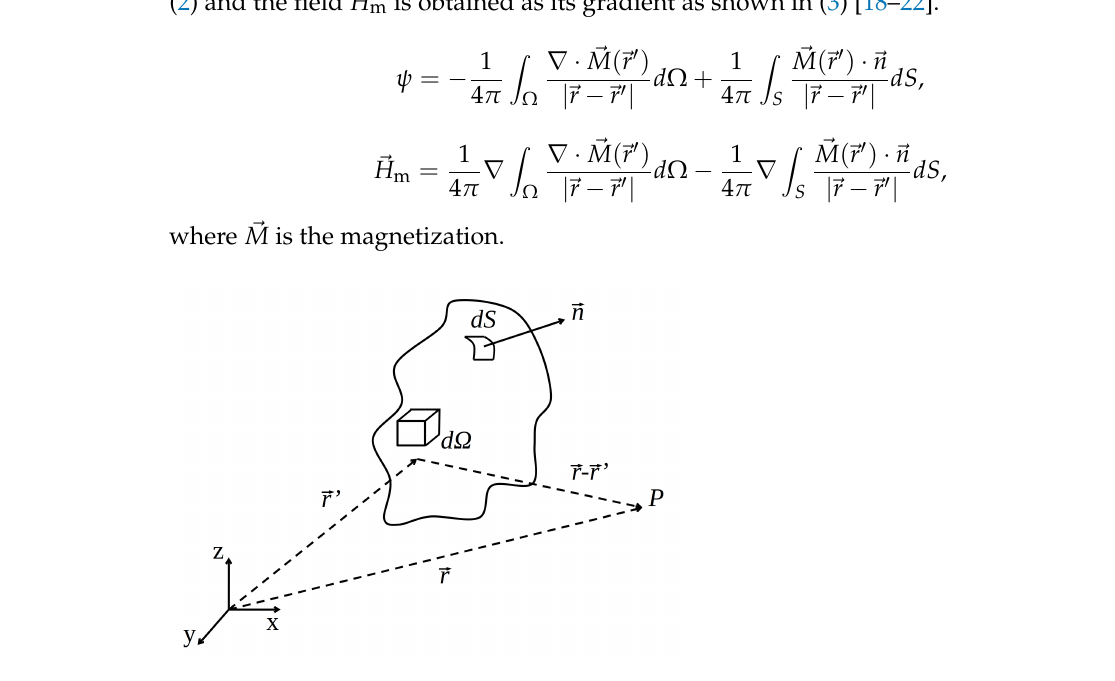
Figure 3. Integration domain for the computation of H m .